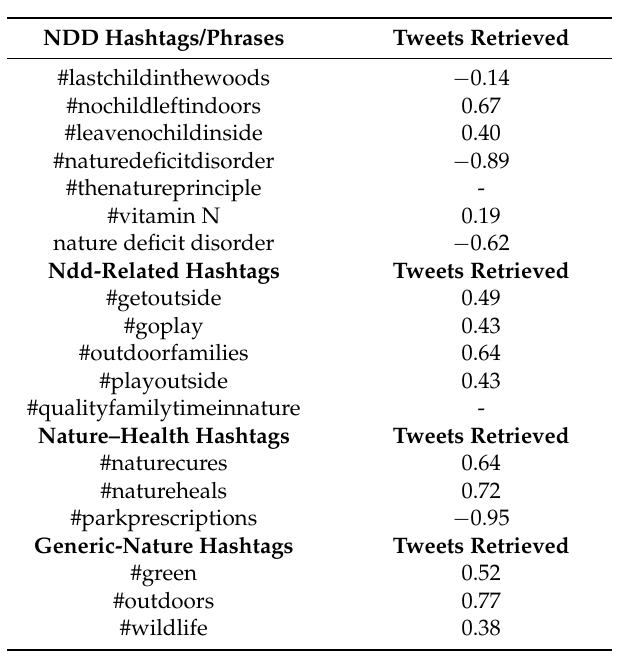
Table 7. Net sentiment rate (NSR) per